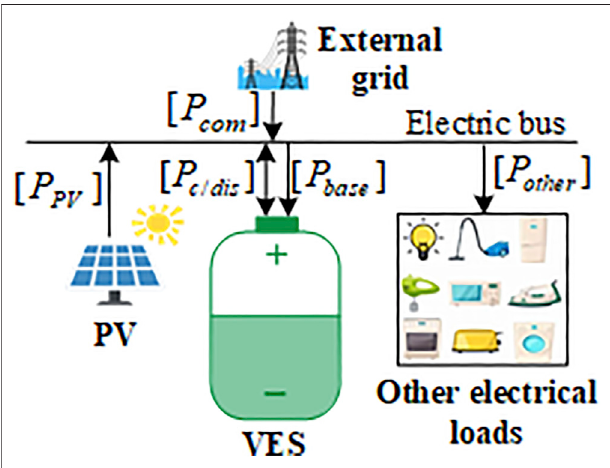
FIGURE 2 | Schematic diagram of the PV-BES with